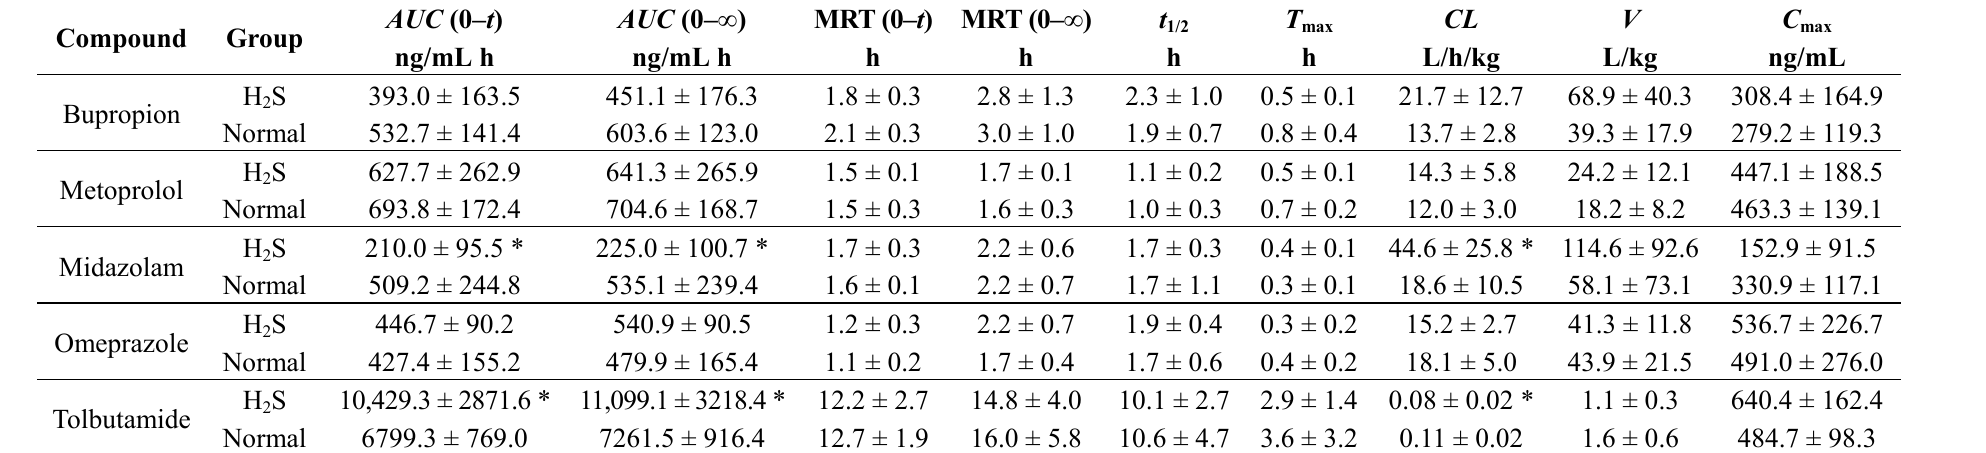
Table 1. Pharmacokinetic parameters of bupropion, metroprolol, midazolam, omeprazole and tolbutamide (mean ± SD), Control-group n = 6, S-group n = H 2